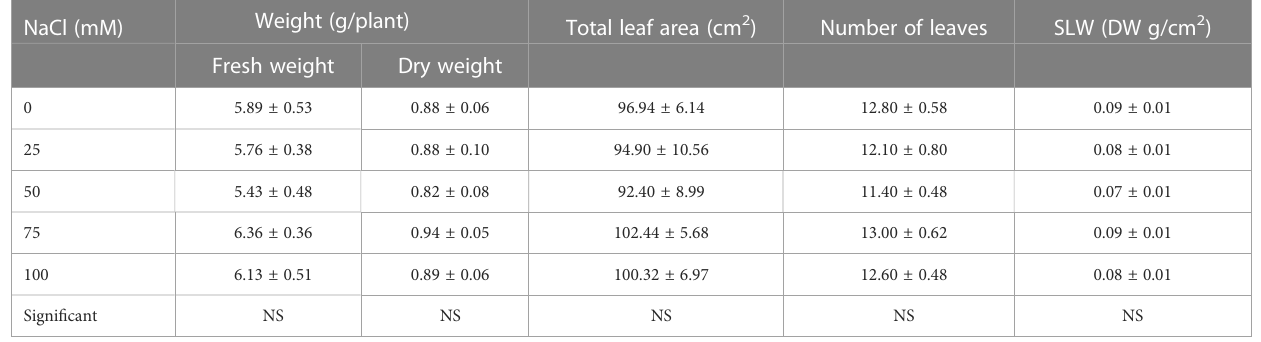
TABLE 1 Growth characteristics of Limonium tetragonum under different NaCl